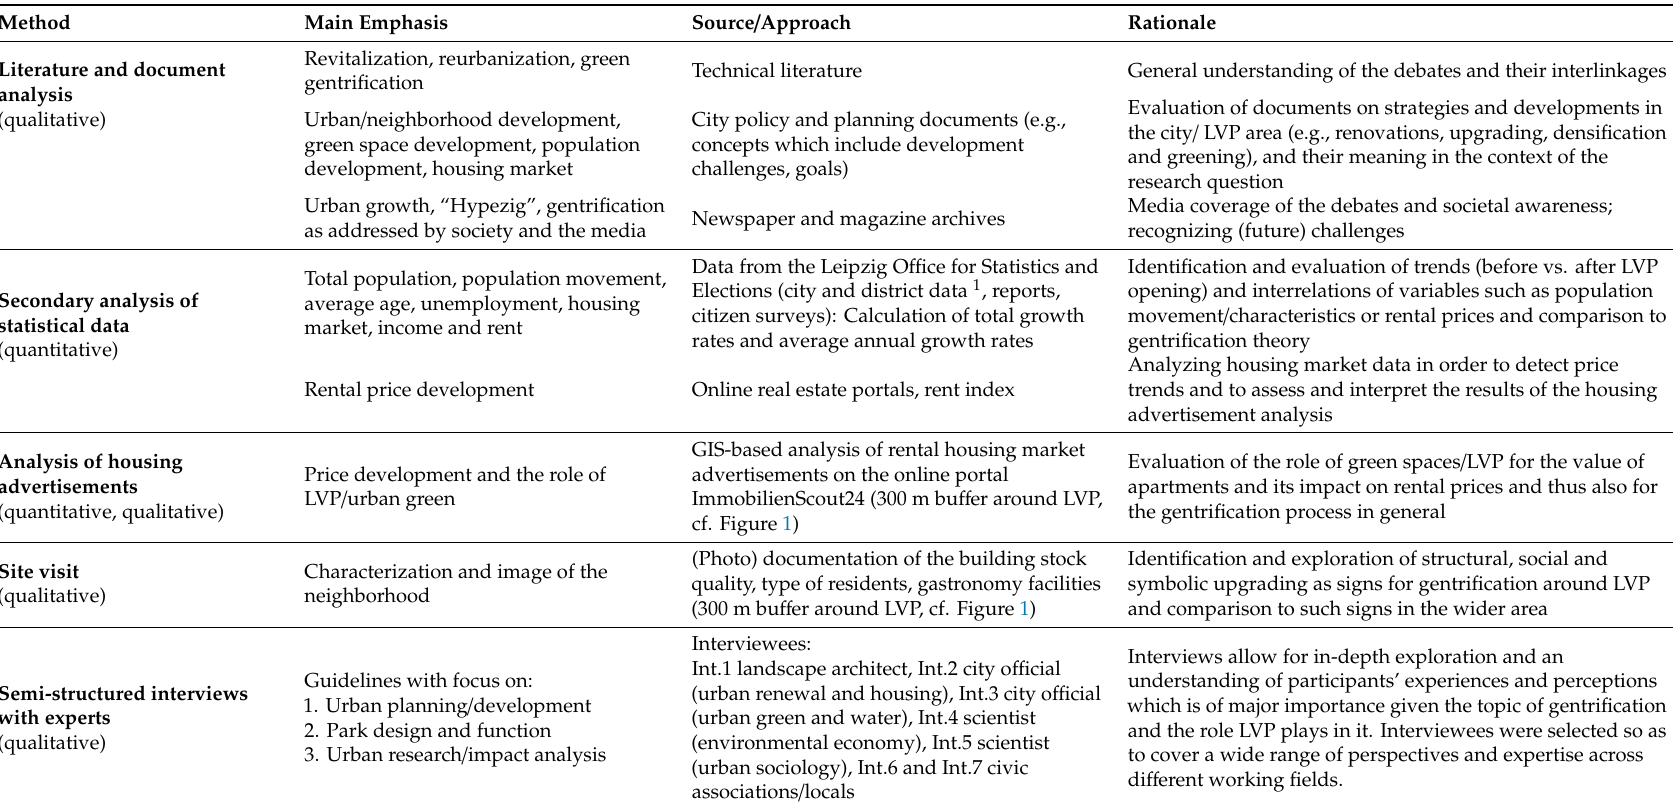
Table 1. Overview of the methods used in the case study ( 1 Leipzig Informationssystem LIS: https: // statistik.leipzig.de / statdist /